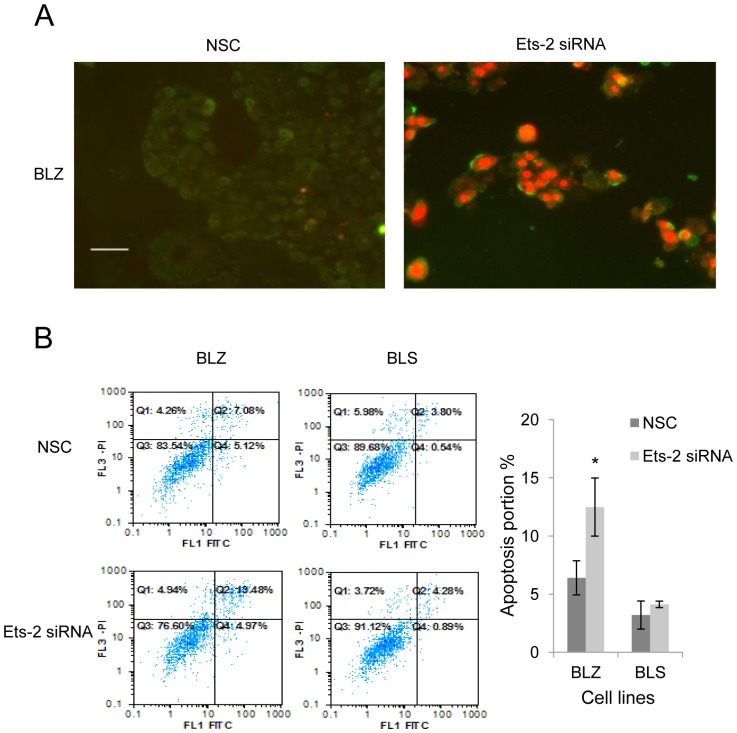
UCA1 may be involved in apoptosis induced by Ets-2 knockdown in BLZ-211 cells.(A) The induction of apoptosis following a 48-hour treatment of Ets-2 siRNA or scrambled control siRNAs in BLZ-211 cells was examined by using a fluorescence microscope. Cells were stained with Annexin V (Green) and PI (Red). Scale bar 25 µm. The images were representative of three independent experiments. (B) Apoptosis was quantified by flow cytometry (FCM). The FCM results were representative of three independent experiments. Cellular pro-apoptosis processes (upper right quadrant) were increased after Ets-2 knockdown in BLZ-211 cells (12.49±1.21% vs. 6.40±1.47%, *P<0.05) while no significant change in BLS-211 cells (4.12±0.28% vs. 3.20±2.50%, P>0.05). NSC: non-specific control siRNA.